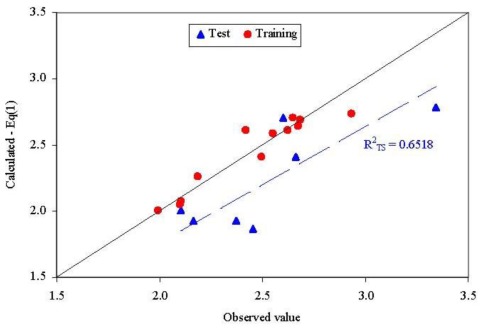
Observed vs. calculated parameter: QSAR-Dragon (Equation (1)R2TS = determination coefficient in test set).